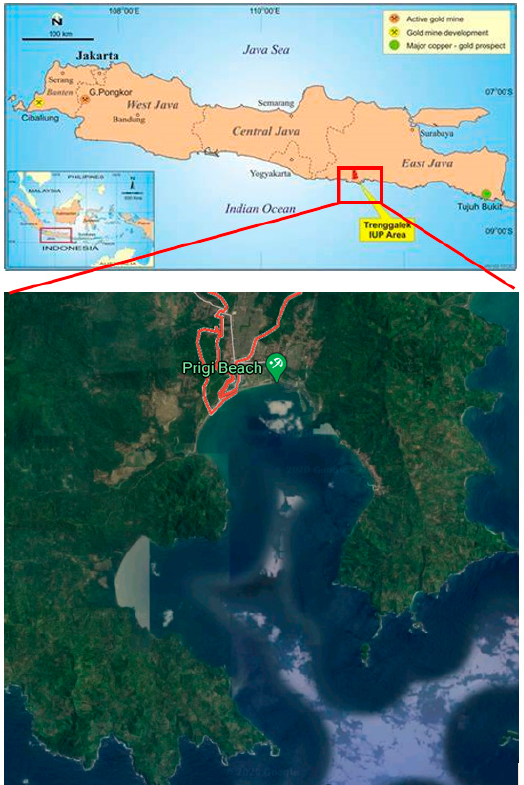
Figure 1. The location of Prigi Bay in east Java Province.